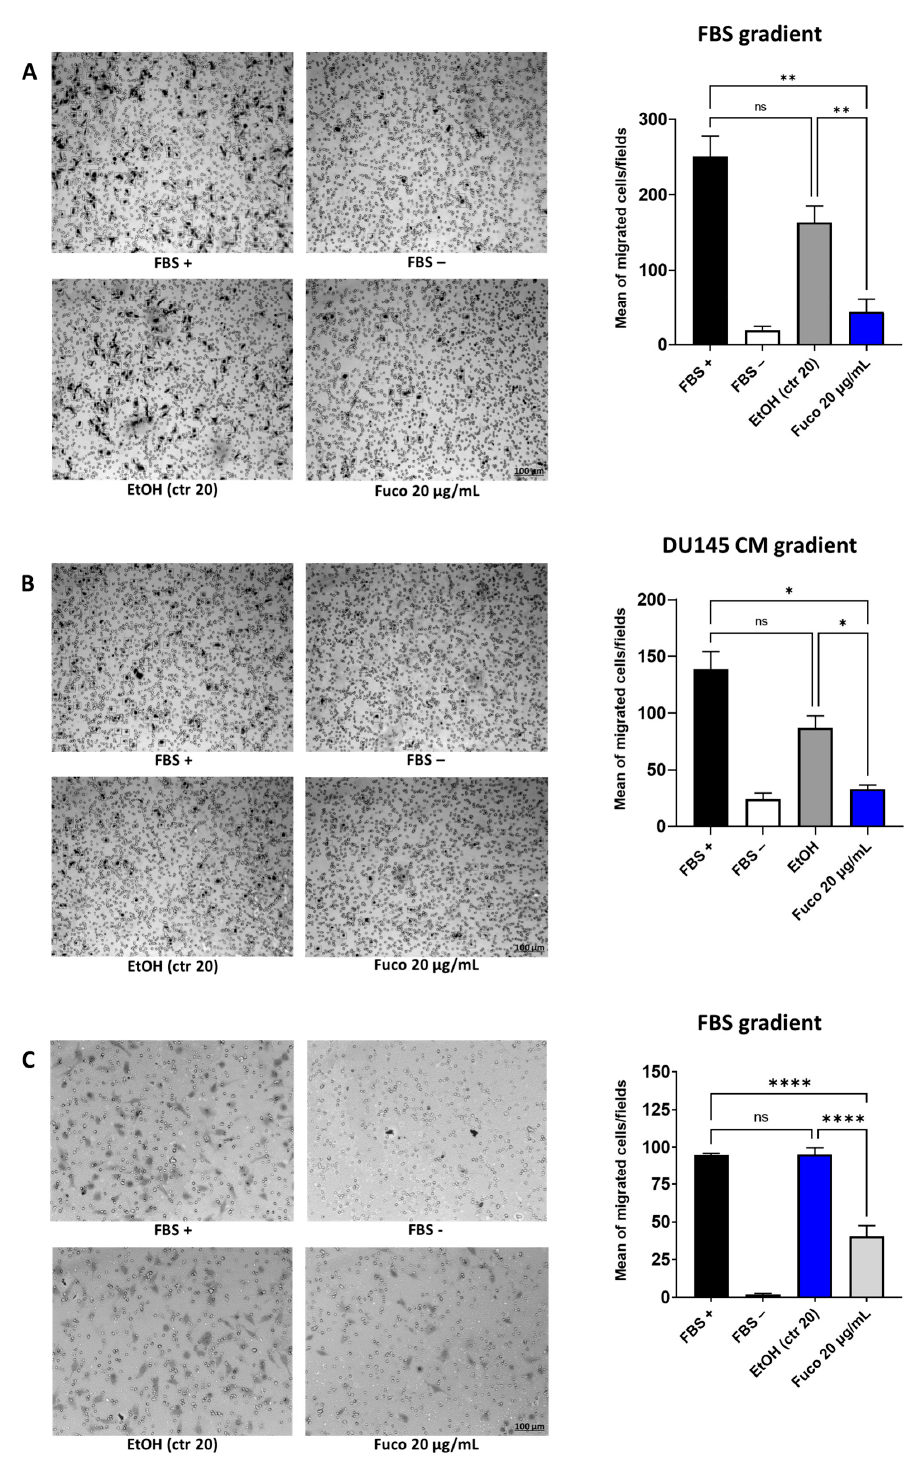
Figure 5. Effects of fucoxanthin on HUVEC migration. Cells were treated with Fuco (20 µ g/mL) or EtOH as the vehicle control, for 6 h. Cell migration was examined using the Boyden chamber assay with FBS ( A ) and DU145 CM ( B ) as chemoattractants and using the transwell assay ( C ) with FBS as a chemoattractant. Photographs of filters were taken at 10 × magnification, representative images are shown, scale bar: 100 µ m. Migration was quantified by counting the number of migrated cells in three independent fields for each experimental condition and data are represented as the mean of the four means calculated for each condition (ImageJ software). Bar graphs are shown, results are shown as mean ± SEM, one-way ANOVA, ns = not significant, * p < 0.05, ** p < 0.01, **** p < 0.0001 vs. FBS+ ( n =